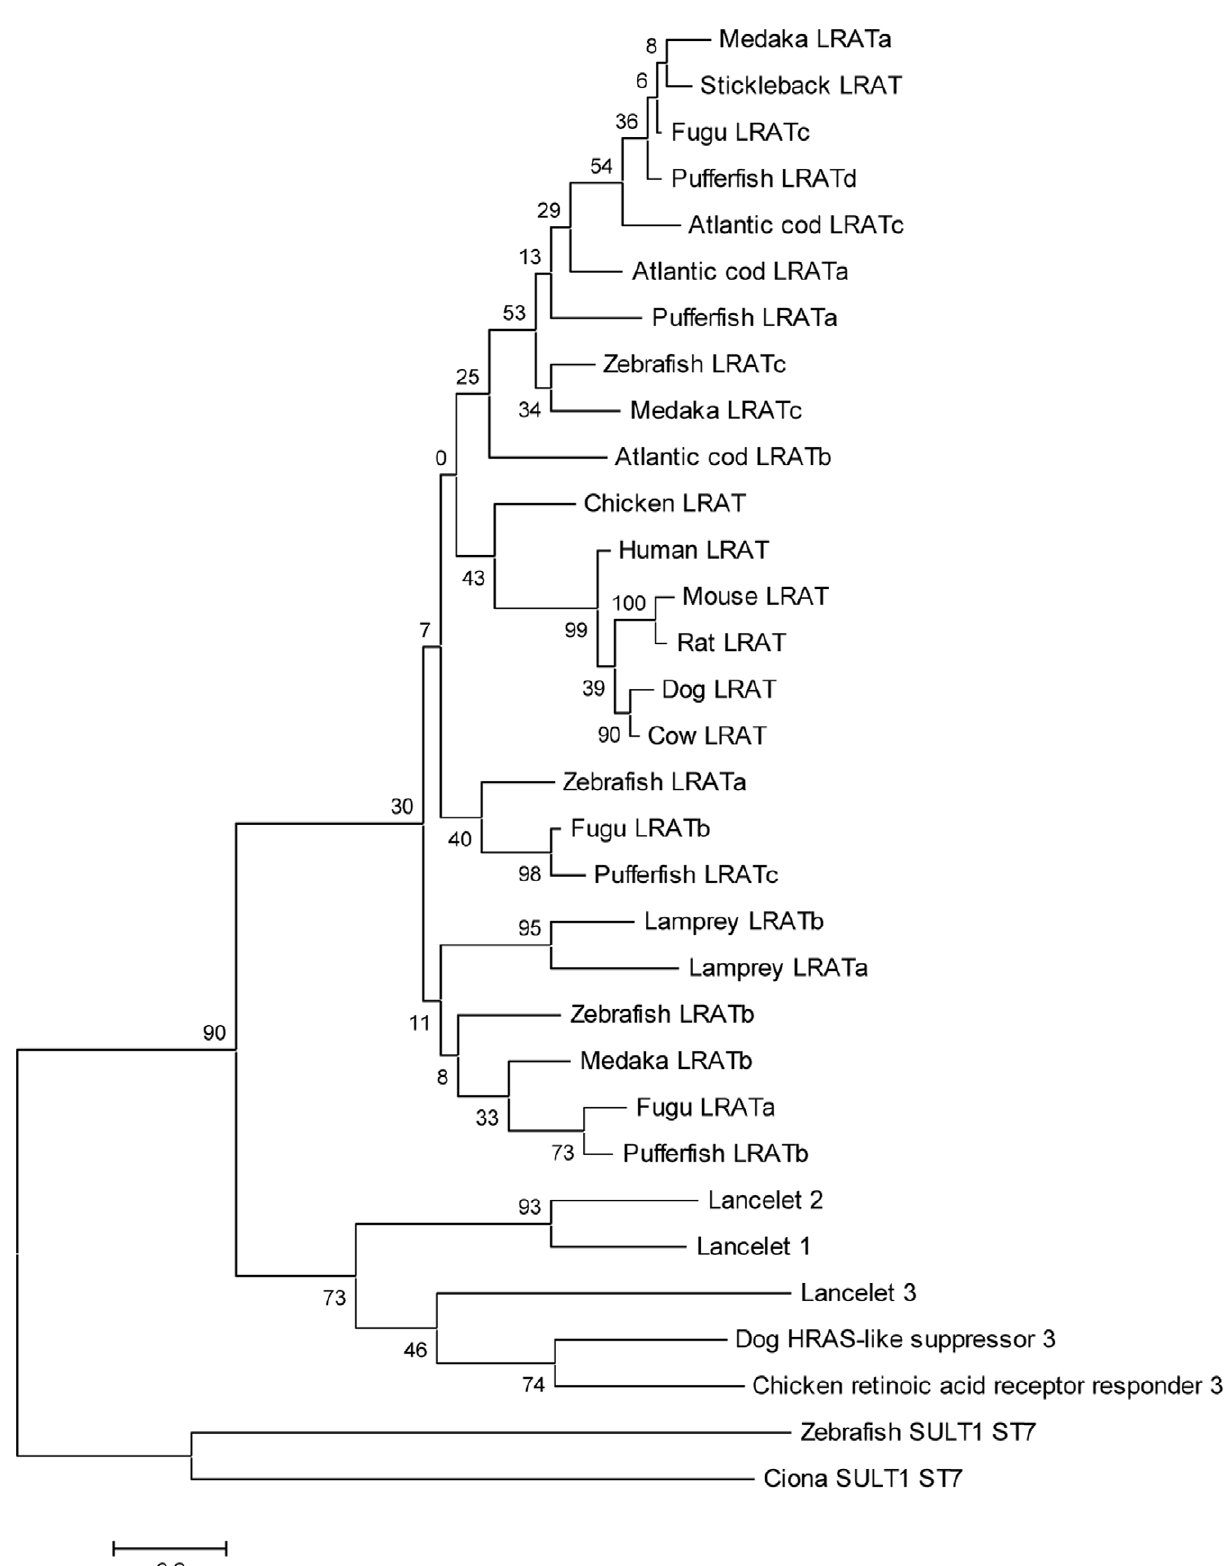
Figure 3. Maximum likelihood phylogenetic tree of the LRAT superfamily (the WAG substitution model, the complete deletion option, the uniform rate of substitutions option as implemented in the MEGA5 program). The numbers for the interior branches refer to the bootstrap values with 1,000 pseudoreplicates.